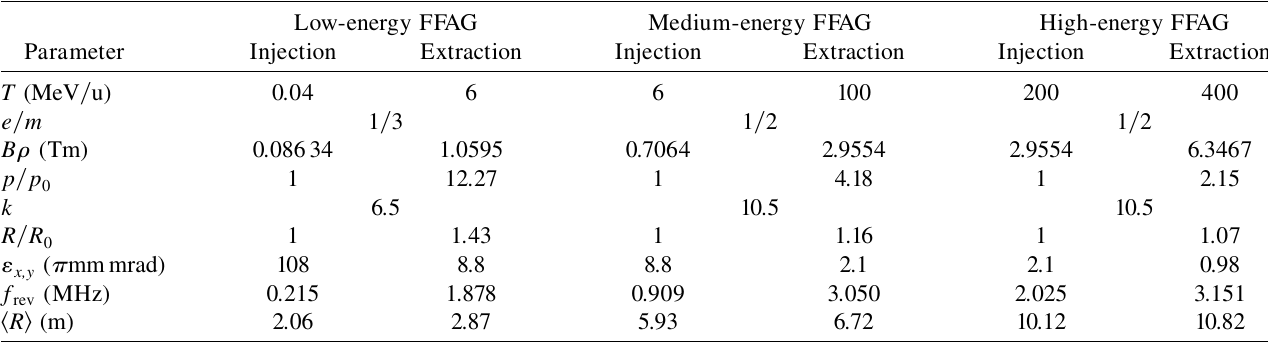
(cid:5) (cid:6) R=R 0